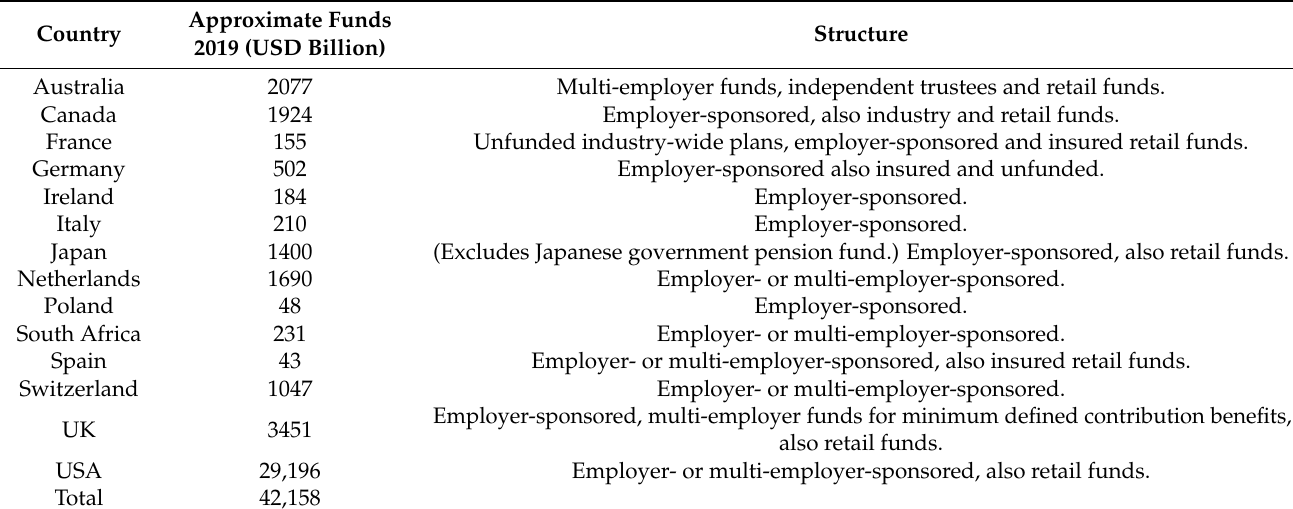
Table 1. Financial assets in employment pension funds (2019). Source: